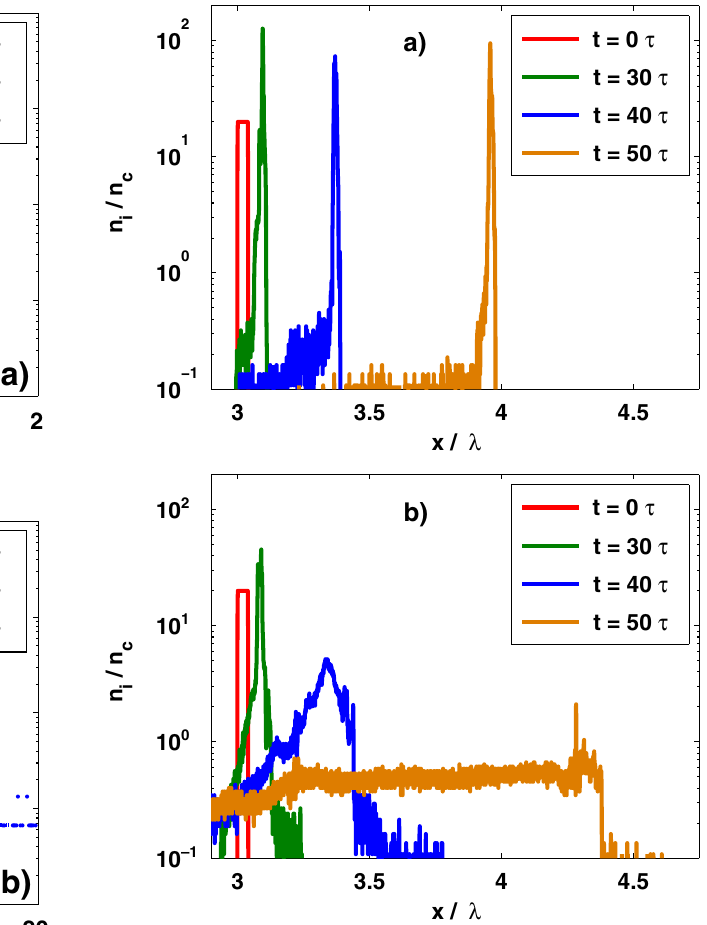
FIG. 2. (Color) Temporal evolution of the ion density profiles obtained in the same simulation as in Fig. 1. The foil irradiated by the CP laser pulse propagates in the laser incidence direction and it conserves its initial volume [panel (a)]. The foil irradiated (cid:3) 1 : 5 (cid:2) by the LP laser pulse explodes [panel (b)]. L (cid:3) e